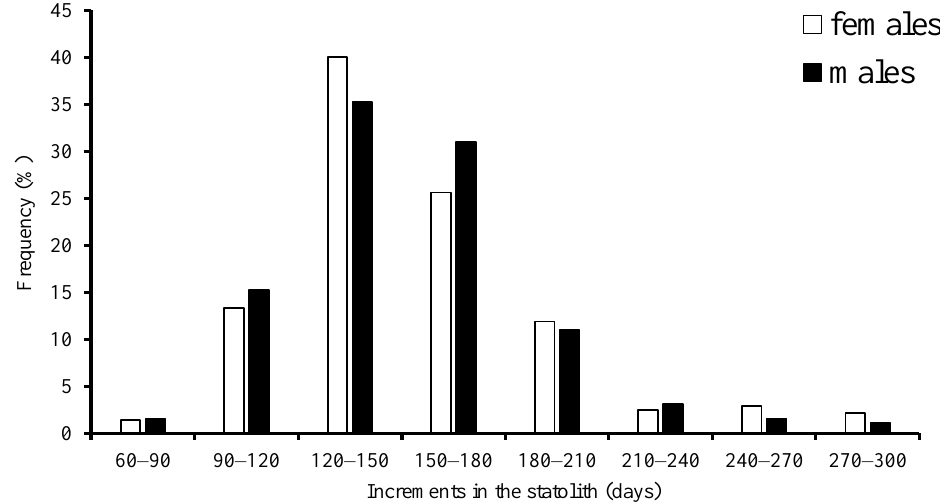
Figure 5. Frequency distribution of age structure for S. oualaniensis in the waters of the Xisha Islands of the South China Sea.